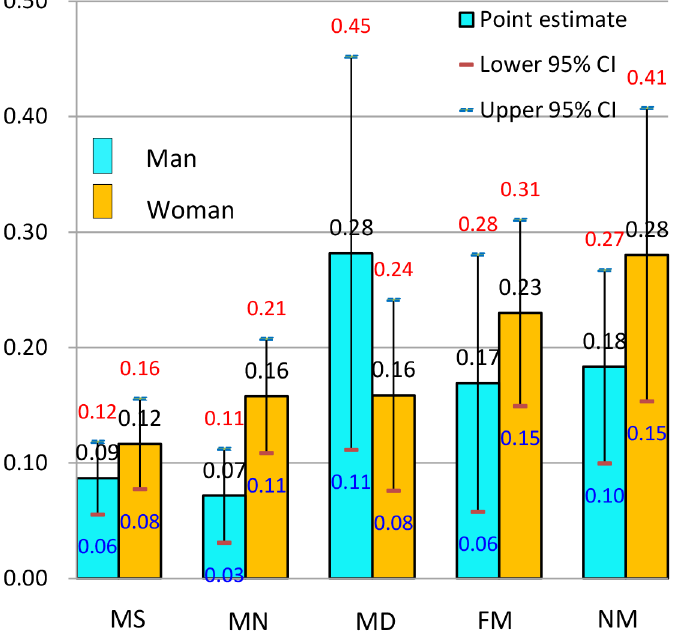
Fig 4. Predicted probability (and 95% confidence intervals) of reporting poor health by gender in South Korea, the 2006 East Asian Social Survey.